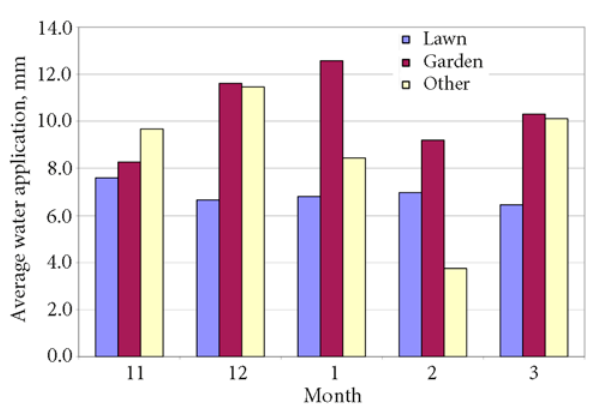
Fig. 3. Average depth of irrigation during different months (11 = November) for the various irrigation zones during the trial period